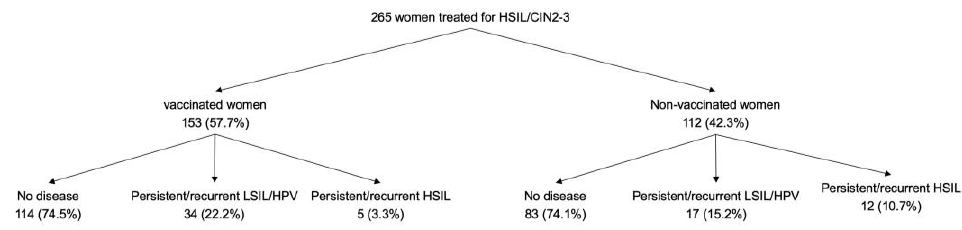
Figure 1. Disposition and clinical outcome at the end of follow-up of the women included in the study according to vaccination status.